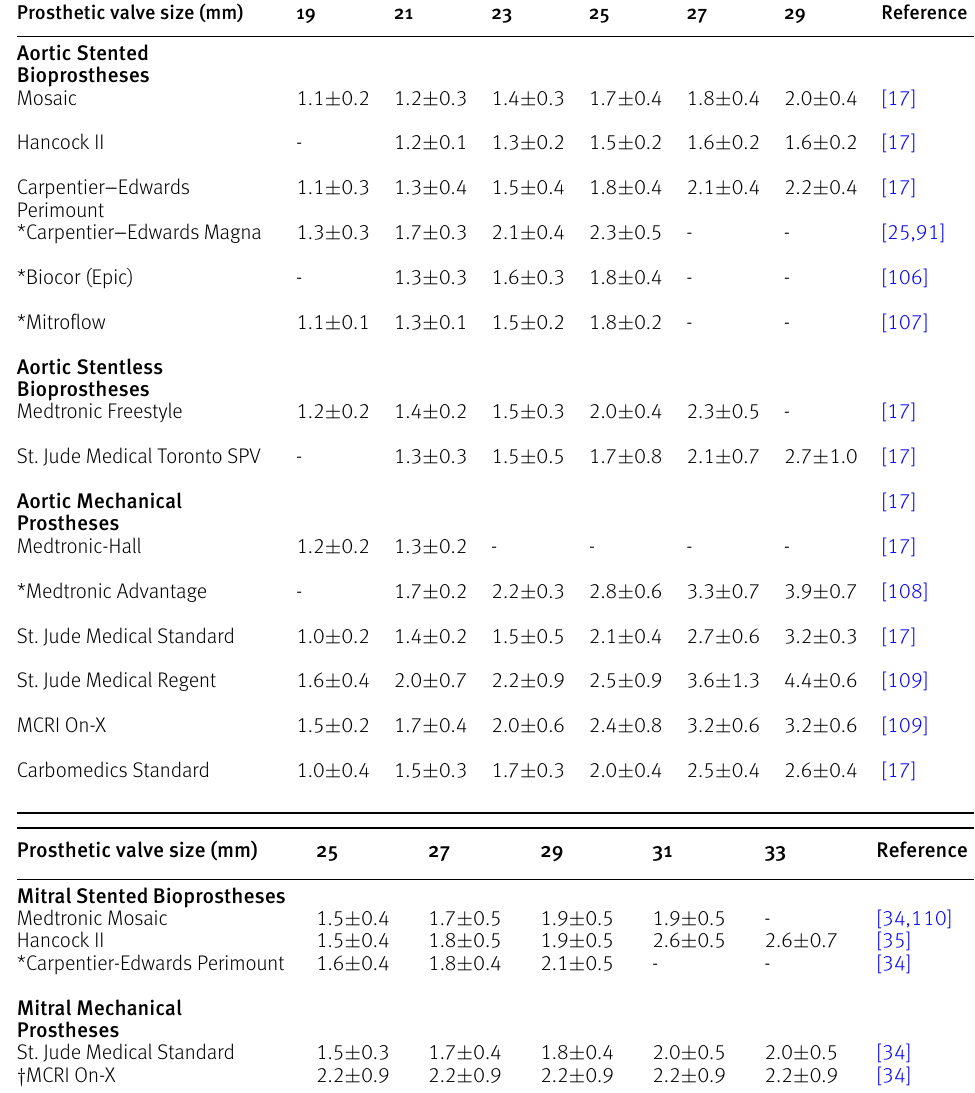
Table 2. Normal reference values of effective orifice areas for the aortic and mitral